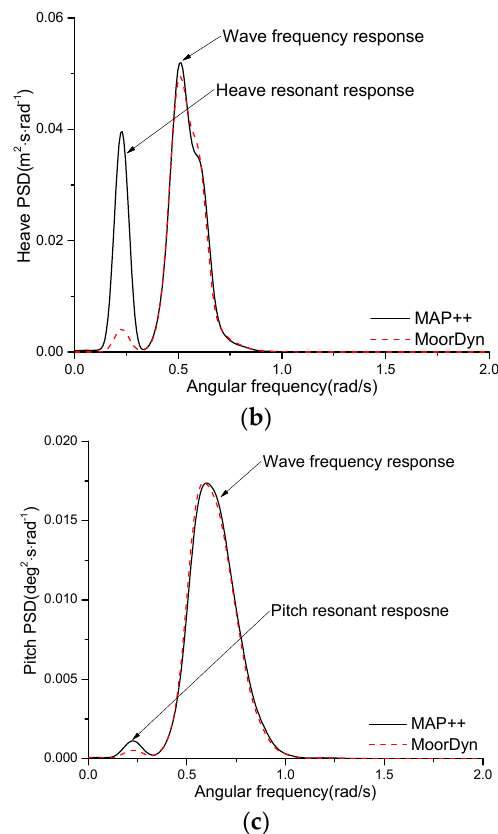
Figure 13. Comparison of motion responses based on the dynamic and quasi-static models. ( a ) Power spectra of surge motion; ( b ) power spectra of heave motion; ( c ) power spectra of pitch motion.